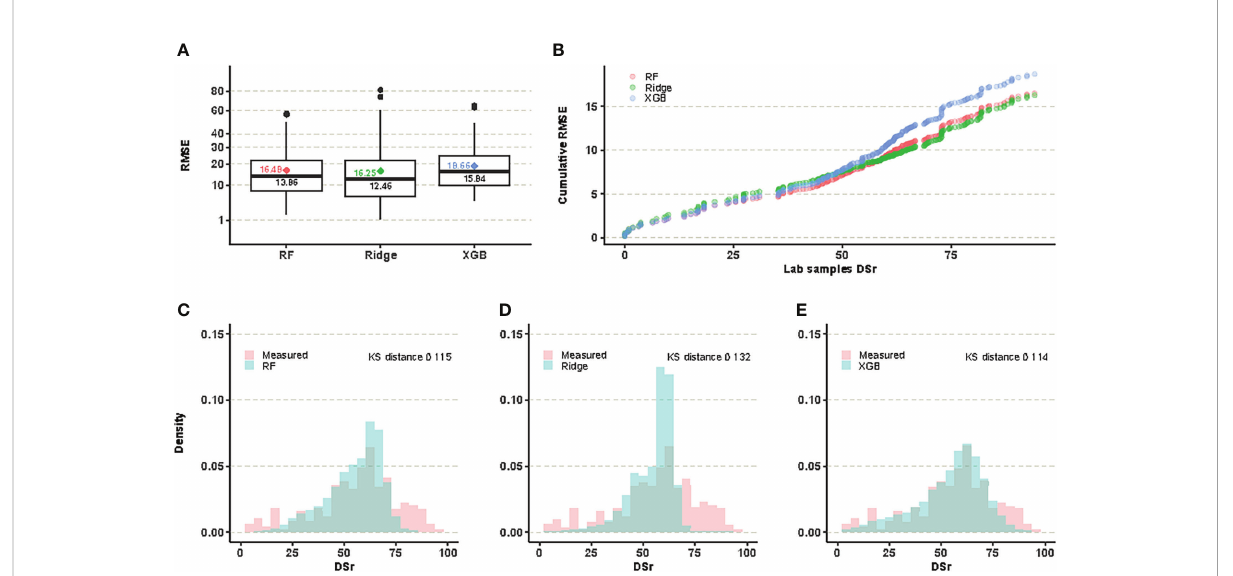
FIGURE 1 (A) RMSE of predicted DSr for evaluated samples for each of the three methods, average values are marked as color- fi lled diamonds. (B) The cumulative RMSE per sample is the sum of RMSE over the number of evaluated samples, and its value is equal to the average value for the last one. Random Forest is the best performer for low values of DSr. (C – E) plots compare the evaluated data distribution of DSr to the predicted